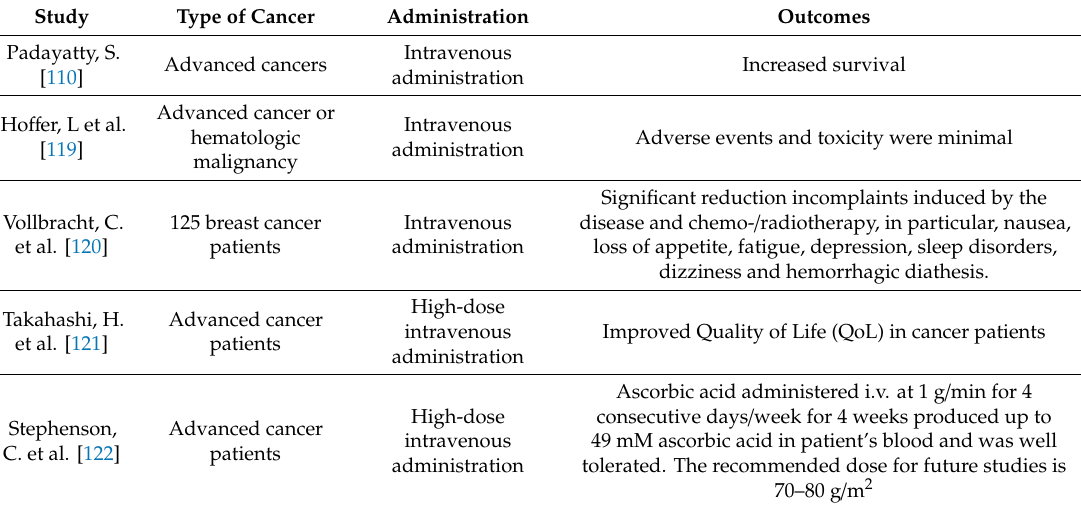
Table 4. Randomized clinical studies in cancer patients treated with